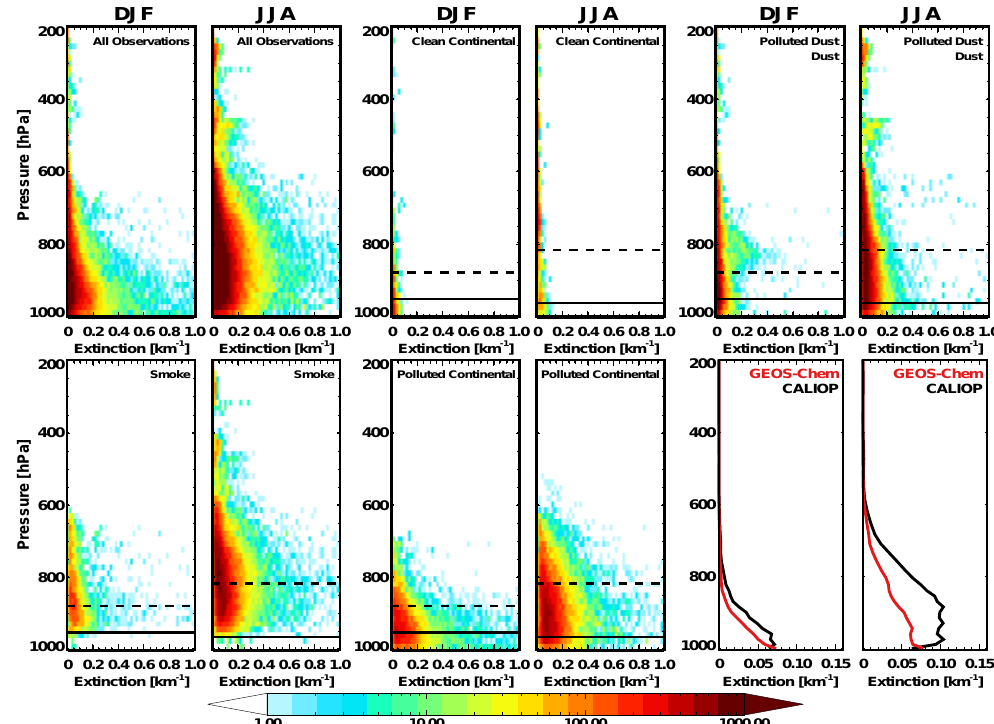
Fig. 5. Density plots of all nighttime aerosol extinction values observed by CALIOP for winter and summer seasons of 2007–2009 over the SEUS (30.5–37.5 ◦ N and 90–81.5 ◦ W), classified by aerosol type. The color denotes the number of observations with given extinction values at a given altitude. There are ∼ 70000 extinction values for the winter and ∼ 200000 for the summer from December 2006–2009, including values below the detection limit. Panels 1 and 2 show observations with all aerosol types noted, and panels 3–10 separate values based on aerosol type, with seasonally averaged boundary layer heights from GEOS-Chem for nighttime (solid black horizontal lines) and daytime (dashed lines) overlaid. Bottom right panels show average aerosol extinction profiles as observed by CALIOP (black) and the corresponding profiles simulated by GEOS-Chem and sampled to the CALIOP overpasses (red) for the two seasons applying detection limits as in Ford and Heald